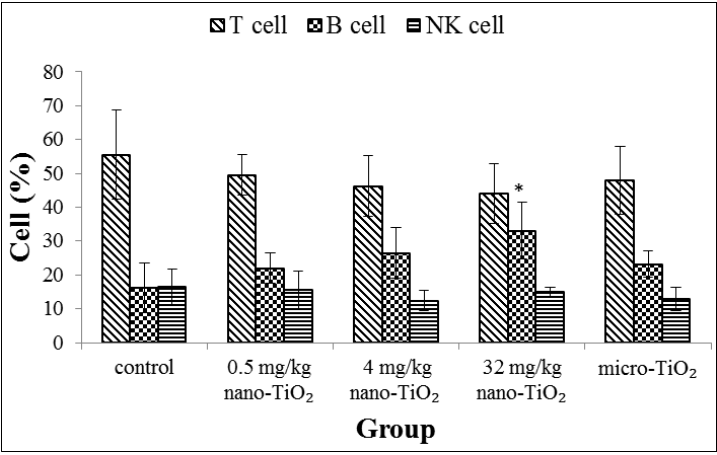
Figure 4. Lymphocyte population distribution of peripheral blood from rats exposed to nano-TiO for 28 days by intratracheal instillation. * represents significantly different from 2 control group ( p <